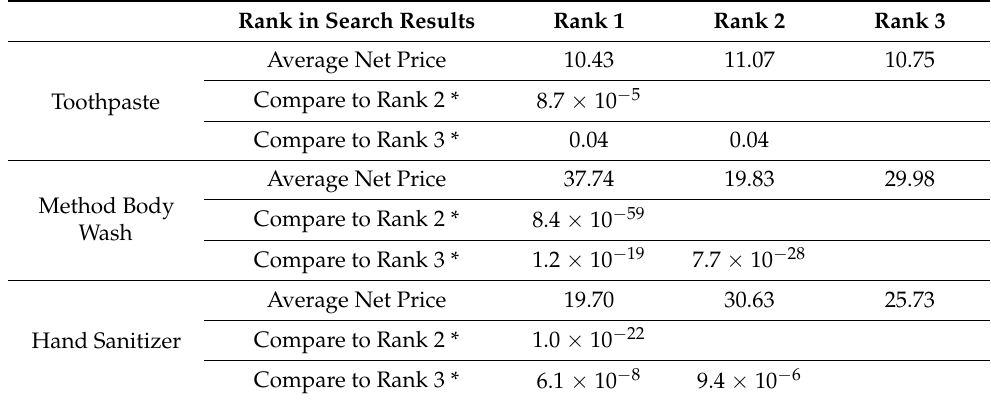
Table 6. Comparison between the price of a product and where it appears on the search results. * Comparison is performed using the paired one-tail